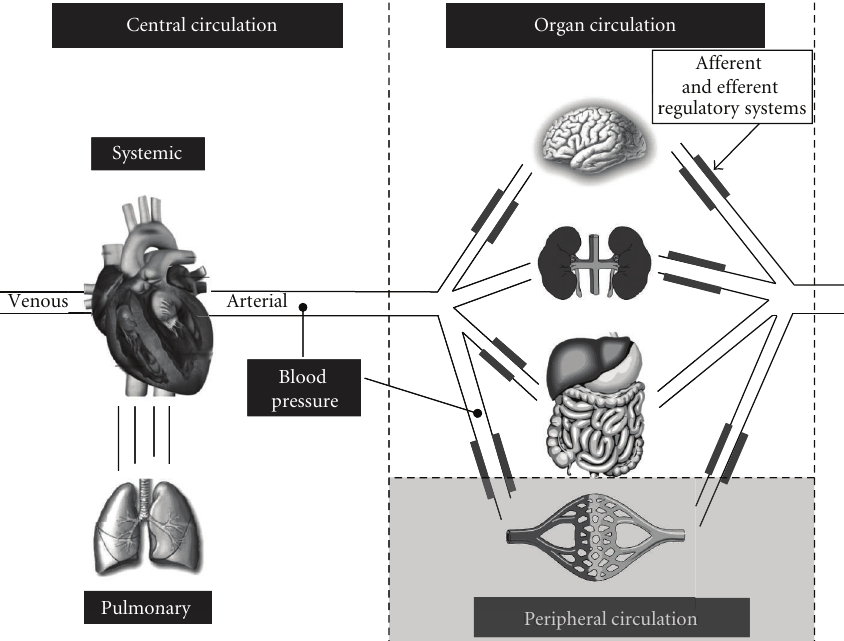
Figure 1: Compartments of the circulation where blood flow can be measured. The central circulation includes the pulmonary and systemic circulation. Organ circulation includes each organ and the peripheral circulation. All organs have their local a ff erent and/or e ff erent regulation system. Blood pressure in newborns is measured in the central circulation (descending aorta) or in the peripheral circulation